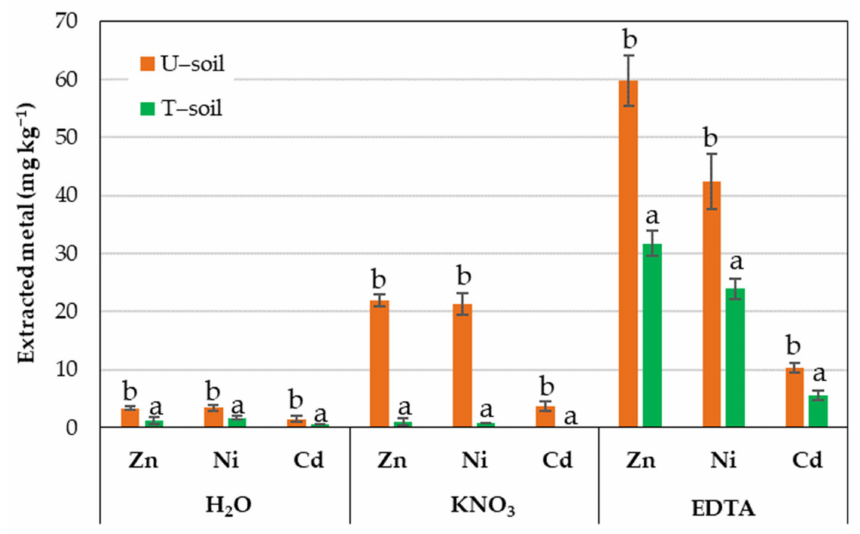
Figure 2. Concentration (mg kg − 1 dry weight) of metals extracted by the sequential procedures in different soil samples. Data are expressed as the means ± SD (n = 3). Different letters indicate significant differences ( p < 0.05) in concentrations between U-soil and T-soil in each fraction of the